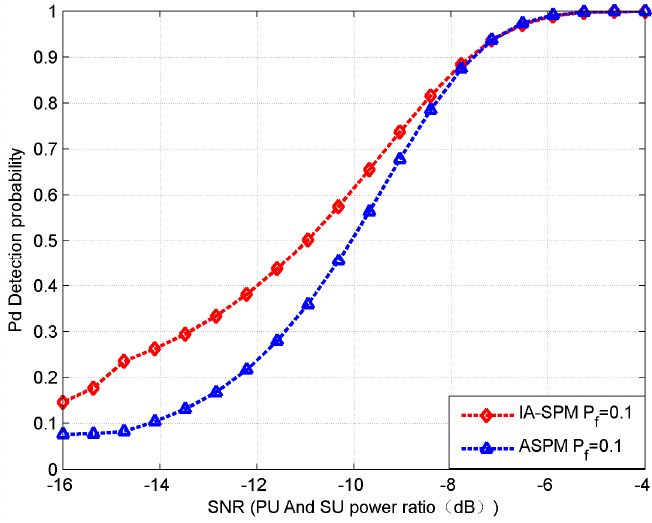
Figure 7. The IA-SPM vs. the ASPM.